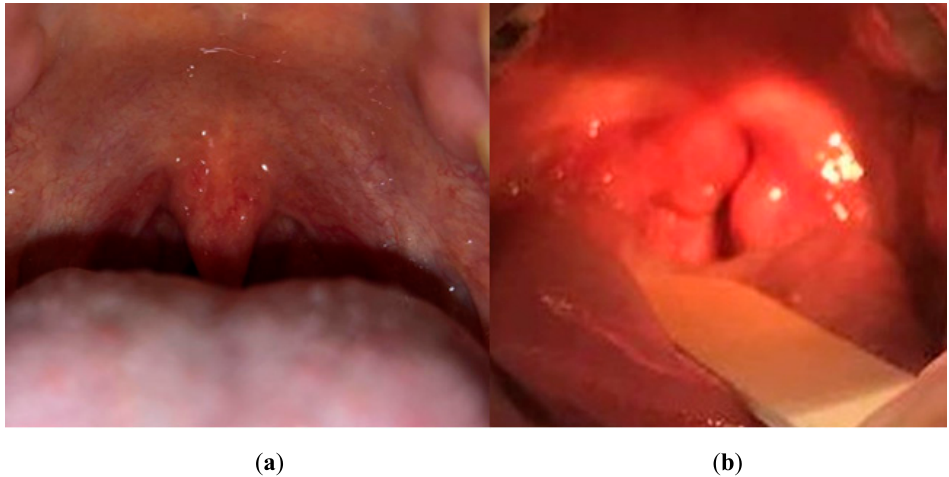
Figure 1 . Example of a healthy and strep throat. ( a ) Healthy throat where there is no sign of any infection, and ( b ) strep throat where there are red swollen uvula and tonsils, and whitish spots on the